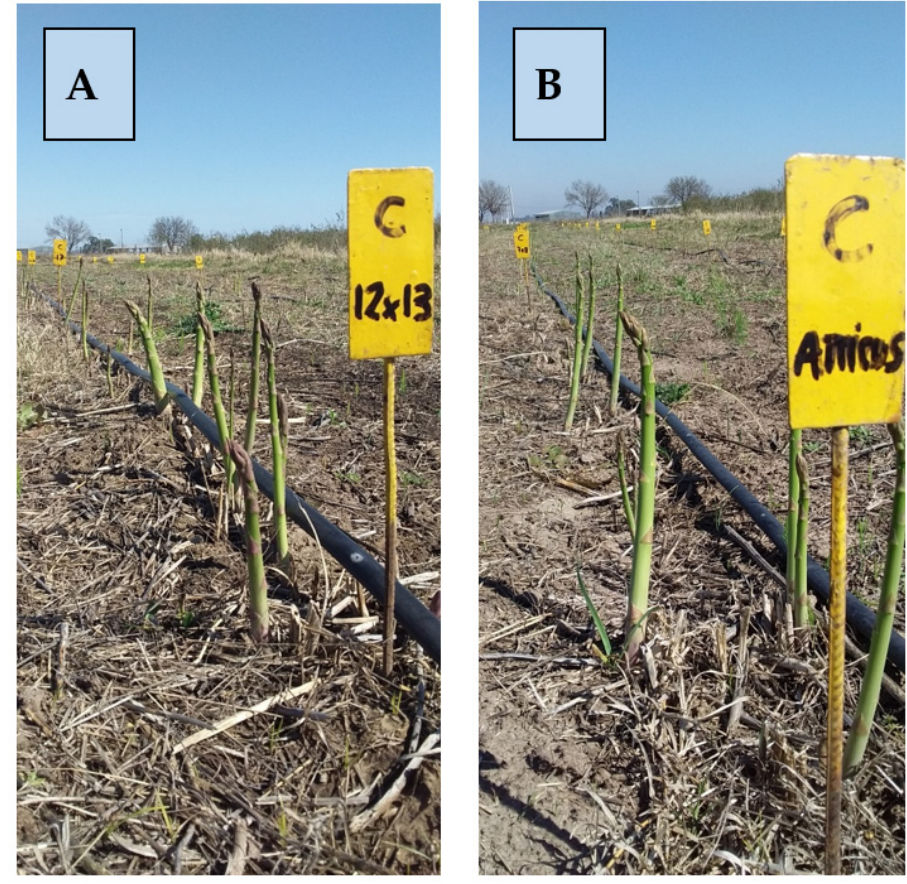
Table 6. Best parent heterosis percentage of market yield for the experimental hybrids in Set 1 and Set 2. For each set, values are presented in decreasing